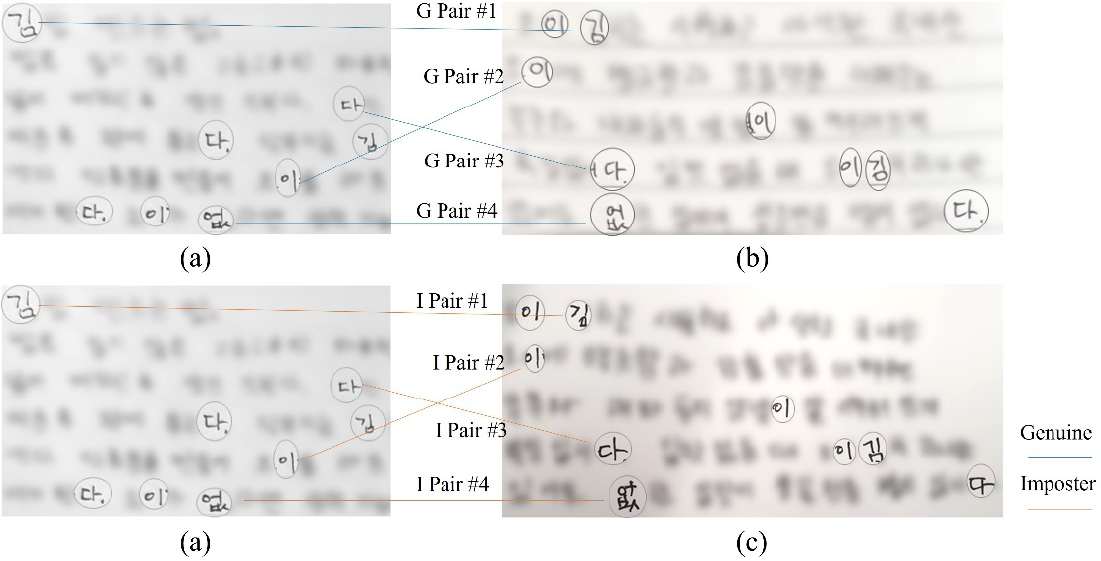
Figure 2. Combination example of each character of genuine and imposter pair. ( a ): Text #1 written by person A, ( b ): Text #2 written by person A, ( c ): Text #2 written by person B.